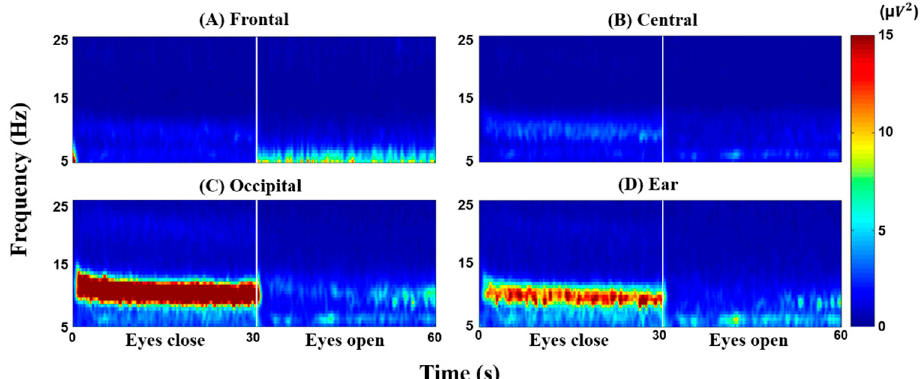
Figure 3. Grand average time-frequency maps with eyes closed (EC) and eyes opened (EO) for ( A ) frontal, ( B ) central, ( C ) occipital, and ( D ) ear area. The color scale was chosen to fit the range for ( D ) ear area.